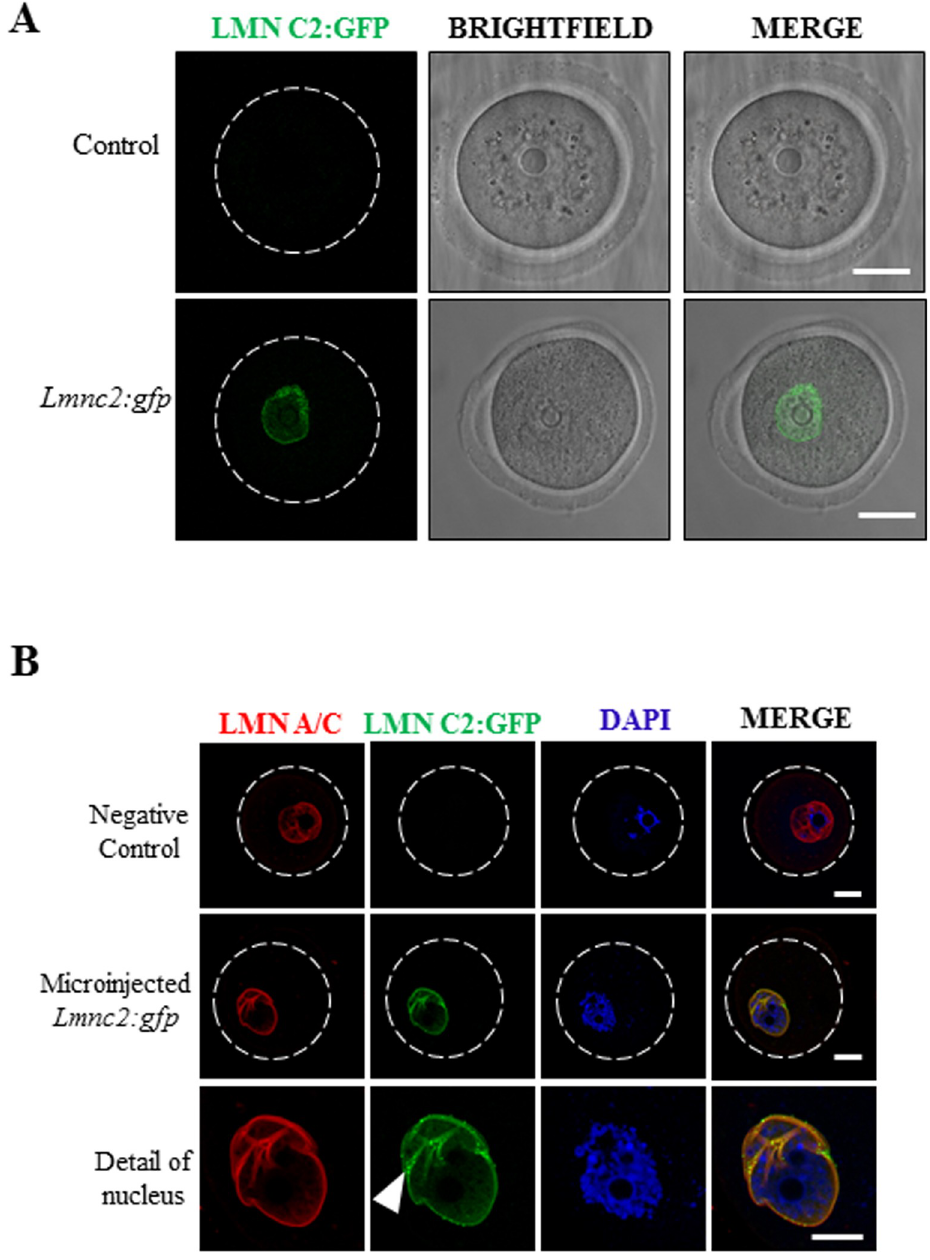
Fig 2. LMN C2 is localized at the nuclear membrane in mouse oocytes. A) Expression and localization of LMN C2: GFP in living oocytes. Scale bar, 25 μ m. B) Expression of LMN C2:GFP (green) and immunocytochemical detection of endogenous lamin A/C using pan-LMN A/C antibody (red). DNA stained by DAPI (blue). White arrowhead depict LMN C2:GFP puncta. Scale bar, 10 μ m. Representative images from at least three independent experiments are shown. See also Fig